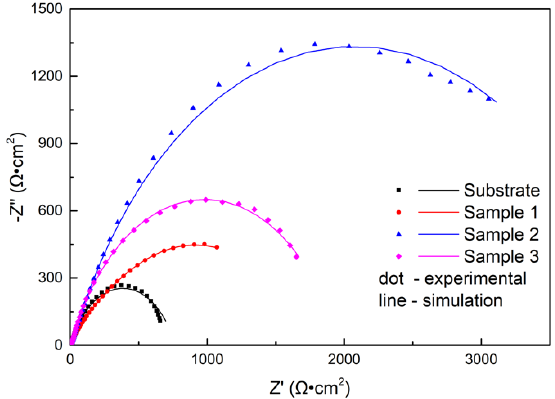
Figure 10. Nyquist diagrams for the substrate and cermet coatings at various laser powers.